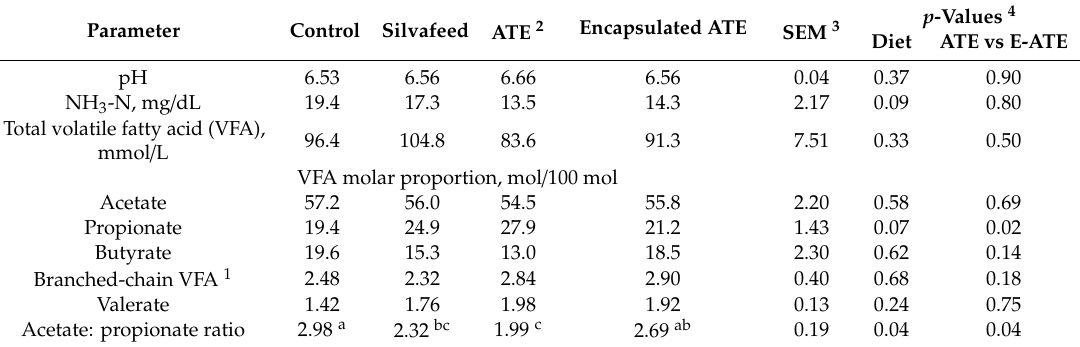
Table 4. Ruminal fermentation characteristics in Merino wethers fed total mixed ration containing crude extracts or lipid-encapsulated Acacia tannin extract (ATE) and silvafeed. Parameter Control Silvafeed ATE